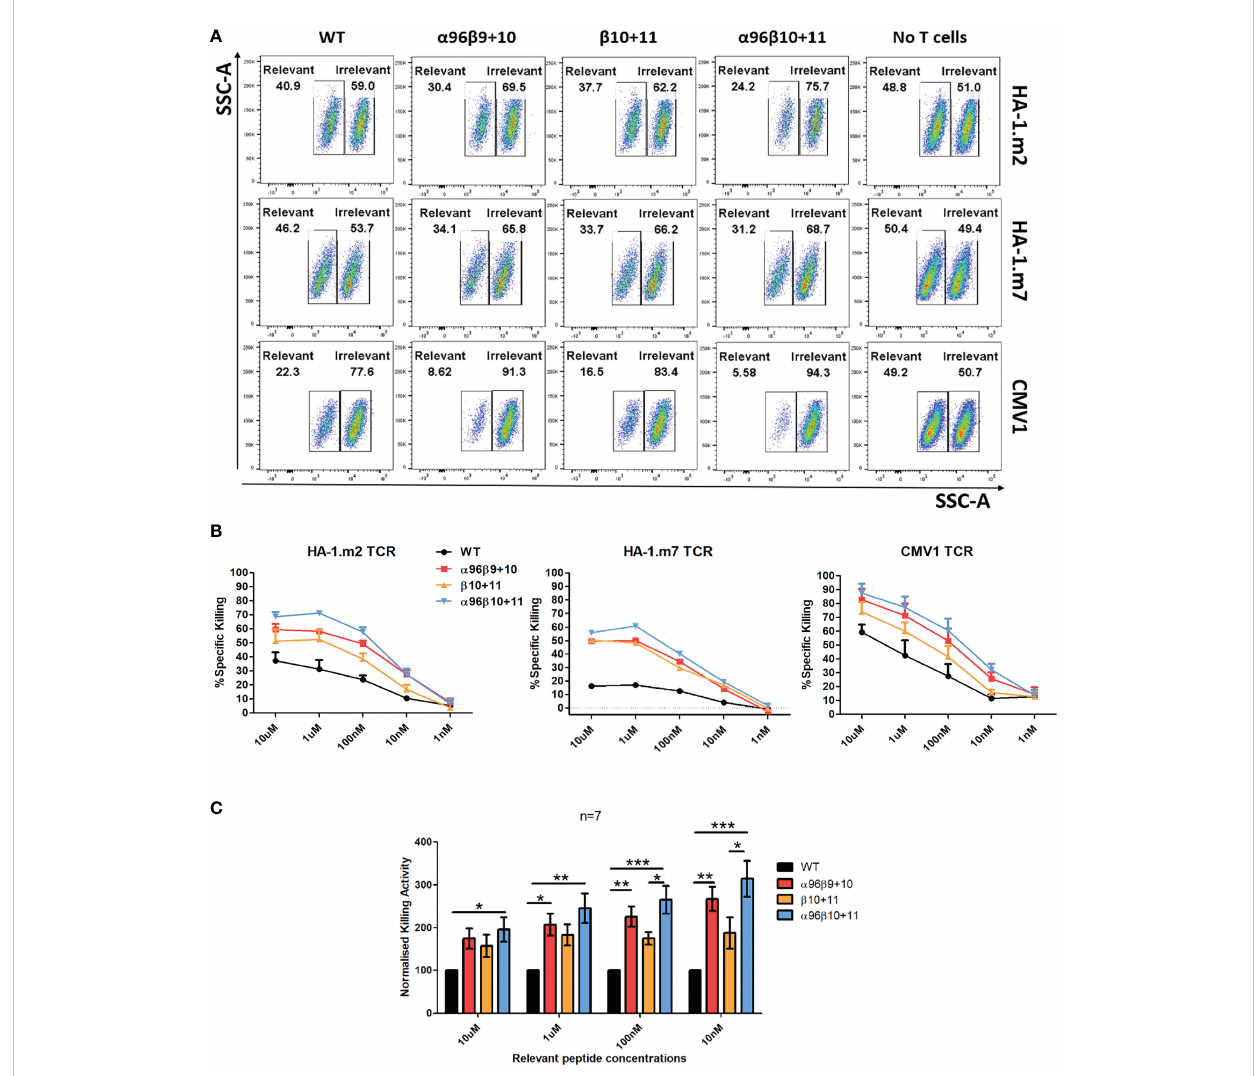
FIGURE 5 Enhanced cytotoxicity was observed with T cells expressing the residue modi fi ed TCRs. Human activated PBMCs were transduced and rested for 8- 10 days and then used in subsequent assays. (A) Cell were co-cultured with T2 cells labelled with 10 m M cognate peptide (low CFSE) or control peptide (high CFSE) mixed at 1:1 ratio (Effector: Target = 2:1). (B) Cell were co-cultured T2 cells labelled with 10 m M – 1nM cognate peptide (low CFSE) or control peptide (high CFSE) mixed at 1:1 ratio (Effector: Target = 2:1). The following day, cells were stained for CD3 and Live/Dead